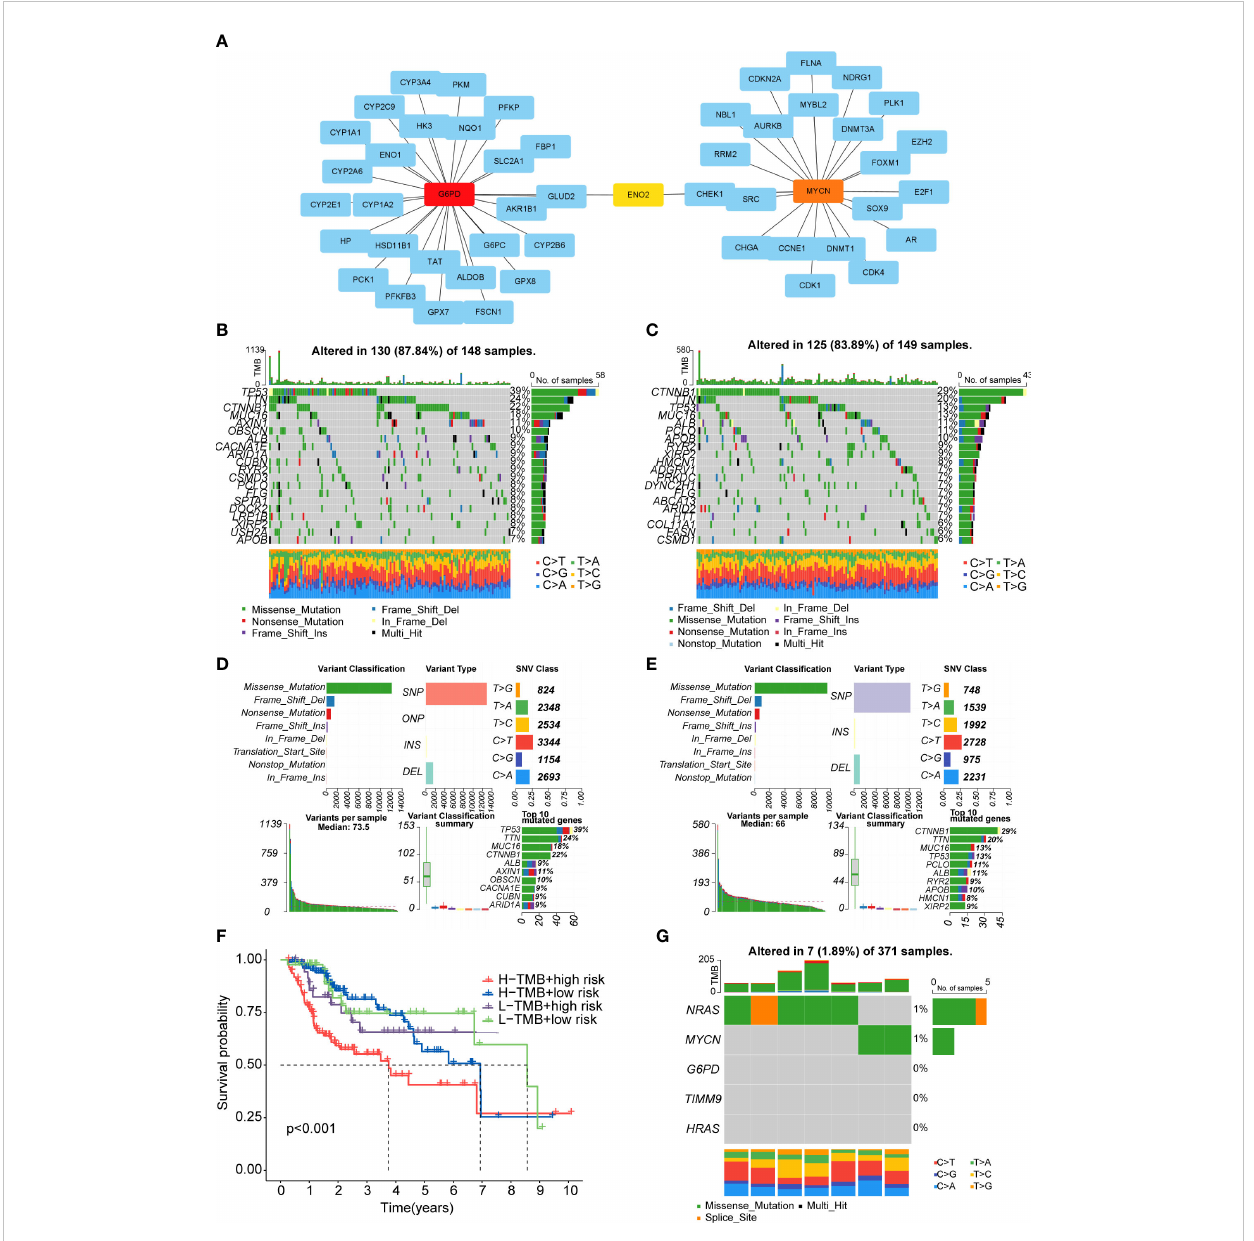
FIGURE 8 PPI network and tumor mutation analysis (A) The PPI network of G6PD and MYCN. (B, C) Waterfall plot of detailed mutation information of top 20 genes in high-risk (B) and low-risk (C) groups. (D, E) Mutation information distinguished by different classi fi cation categories in high-risk (D) and low-risk (E) groups. (F) . The K-M survival curve shows the combined effect of TMB and risk score on the OS. (G) Mutation information of the prognostic